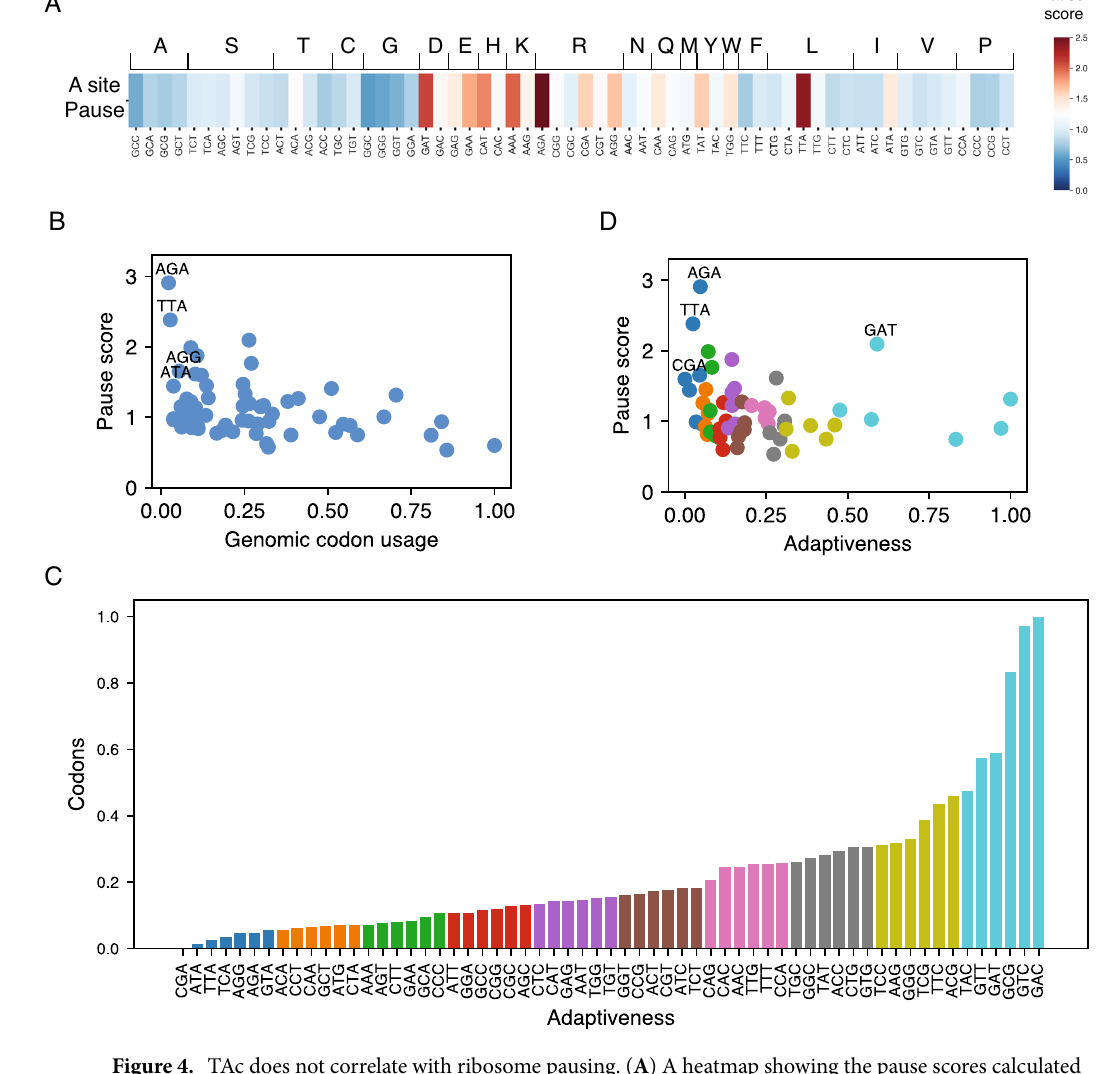
Figure 4. TAc does not correlate with ribosome pausing. ( A ) A heatmap showing the pause scores calculated from the riboseq data. ( B ) A scatterplot comparing pause scores with genomic codon usage. ( C ) A bar plot showing different bins of TAc values. Bins are colour coded and the same colours are used in D. ( D ) A scatterplot comparing TAc with the pause